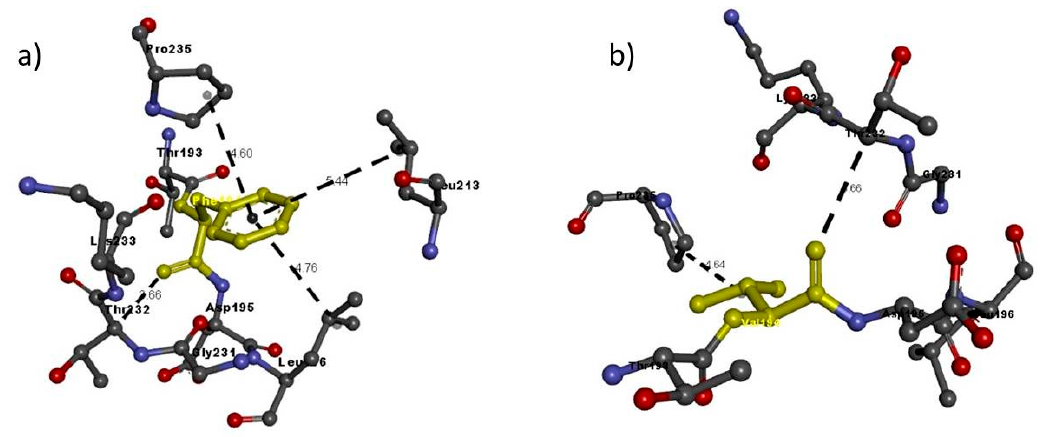
Figure 7. Molecular interactions of ( a ) Phe194 and ( b ) Val194 (in yellow) of the modeled NRP2 protein with adjacent residues.